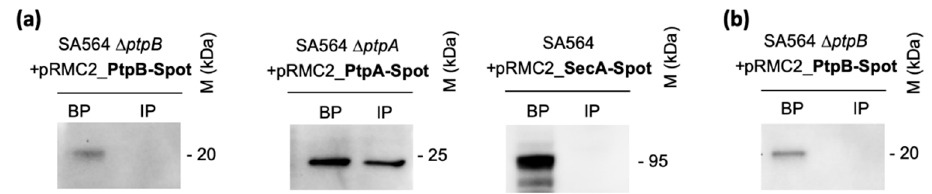
Figure 3. PtpB is not secreted by S. aureus . ( a ) Cultures were induced with 0,2 µg/mL of anhydrotetracycline for 2 h and supernatants from S. aureus SA564 ∆ ptpB + pRMC2_PtpB-Spot, SA564 ∆ ptpA + pRMC2_PtpA-Spot (positive secretion control), and SA564 + pRMC2_SecA-Spot (negative secretion control) were filtered and immunoprecipitated with anti-Spot magnetic beads, whereas bacterial pellets were resuspended and lysed in PBS with protease inhibitor cocktail, lysostaphin, and DNAaseI. Immunoprecipitated proteins (IP) from supernatants and bacterial pellets (BP) were resolved on SDS-PAGEs, transferred to PVDF membranes, and subjected to Western-blot analyses using an anti-Spot antibody as primary antibody (Chromotek) and a HRP-coupled goat-anti-lama antibody as secondary antibody (Bethyl). Data are representative of three independent experiments. ( b ) RAW 264.7 macrophages (5 × 10 5 cells/mL) were incubated in presence of anhydrotetracycline (0.1 µg/mL) to induce PtpB expression after phagosomal uptake of the bacteria for 2 h with S. aureus SA564 ∆ ptpB + pRMC2_PtpB-Spot at a MOI of 20, and non-phagocytosed bacteria were subsequently removed by gentamicin/lysostaphin treatment. At 3 h pGt, infected macrophages were lysed in 0.1 %Triton X-100, and centrifuged at 14 000 g. The obtained supernatants corresponding to macrophage lysates were immunoprecipitated with anti-Spot magnetic beads (Chromotek), whereas the pellets containing intracellular bacteria were resuspended in an equal amount of lysis buffer. Immunoprecipitated proteins and bacterial pellets were resolved on SDS-PAGE and detected with an anti-Spot antibody as described in ( a ). Data are representative of three independent experiments (M kDa: molecular markers).